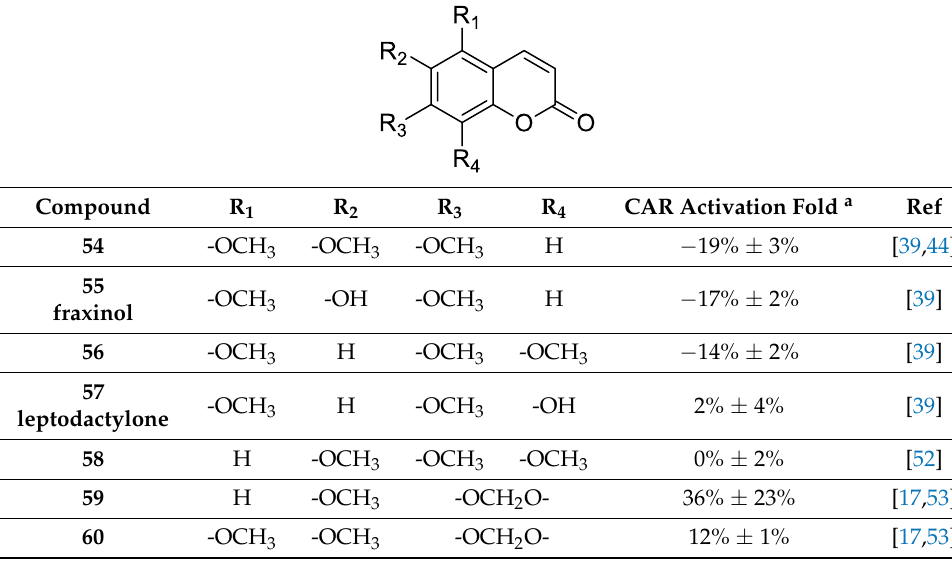
Table 3. Tri- and tetra-substituted coumarins and their CAR activation.